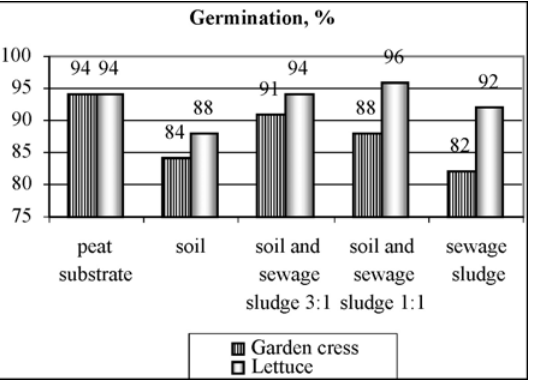
Fig 8. Germination of garden cress and lettuce in sub- strates of different